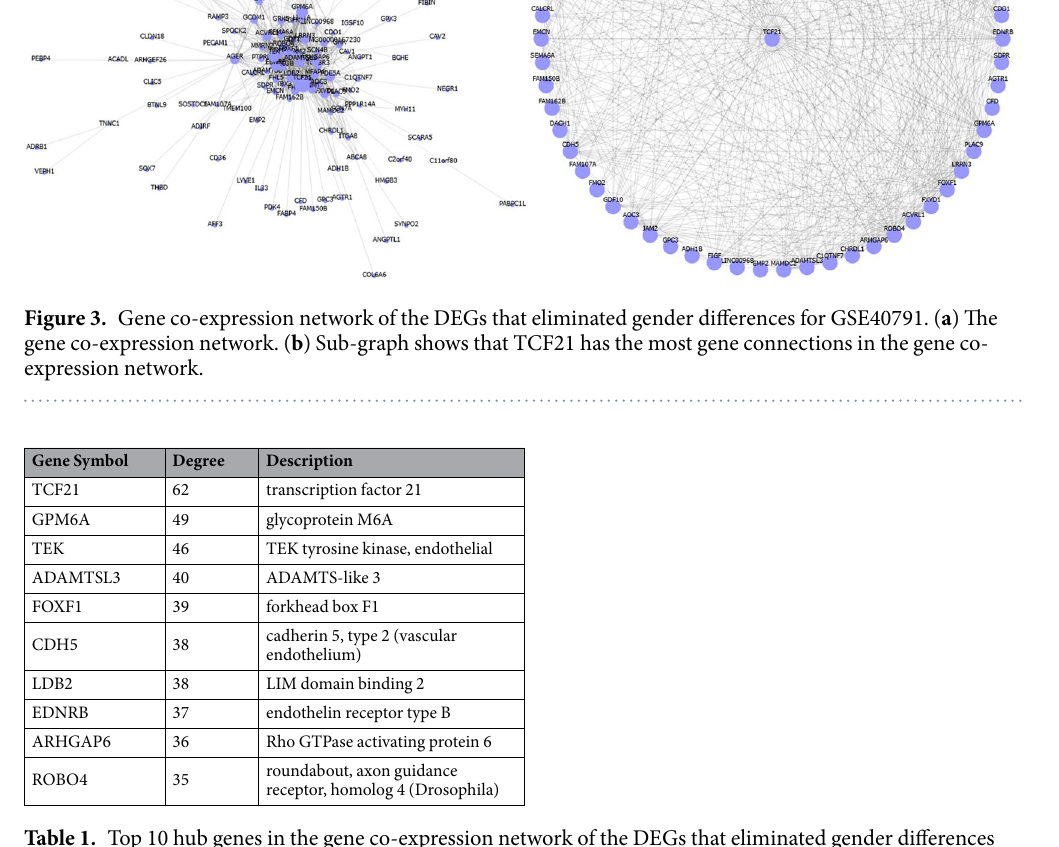
Table 1. Top 10 hub genes in the gene co-expression network of the DEGs that eliminated gender differences for